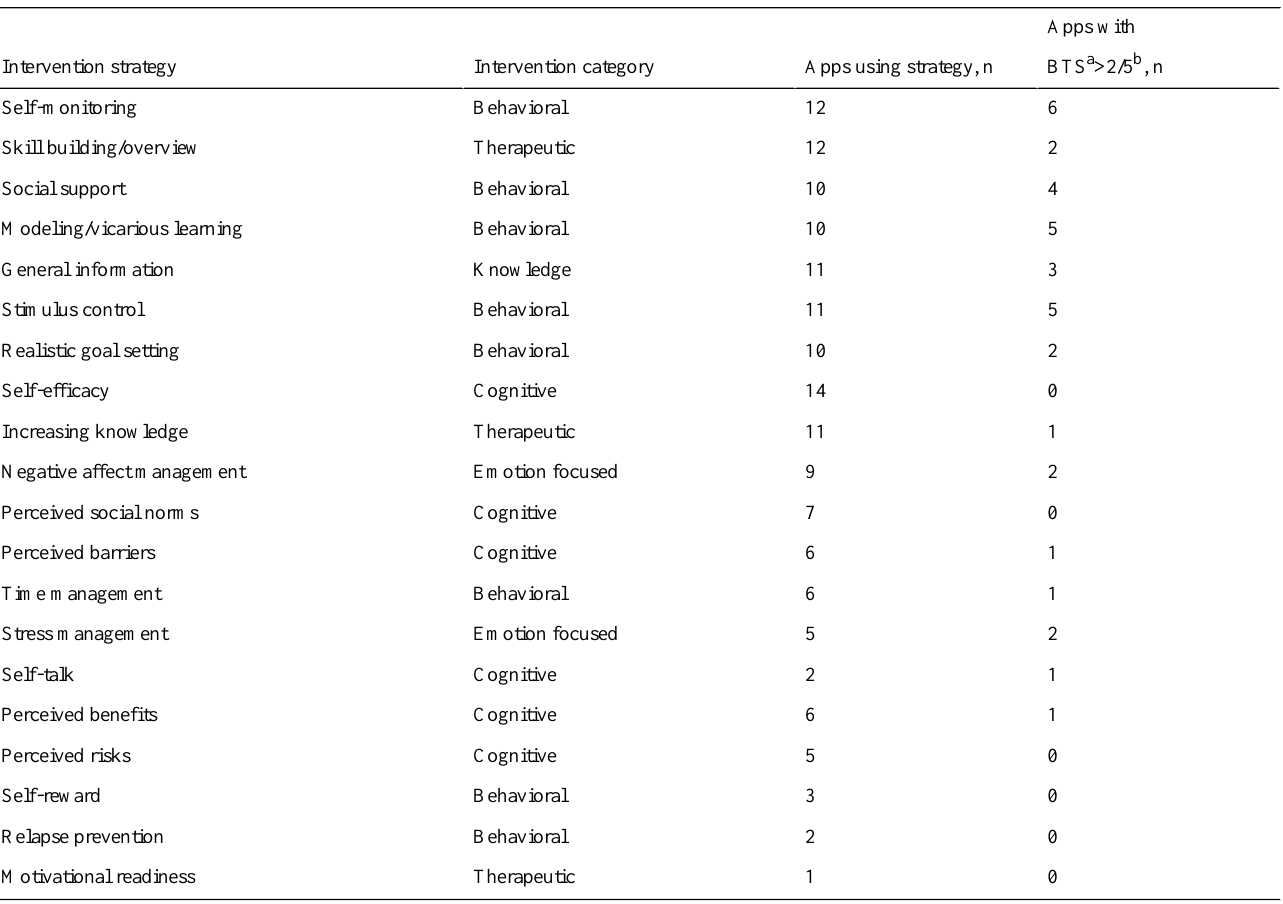
Table 4. Intervention strategy distribution by all apps.